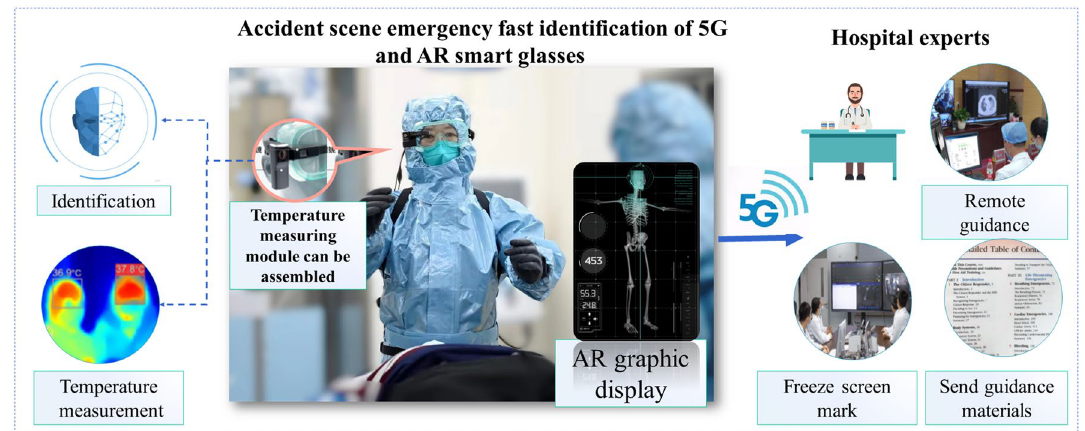
Figure 7. AR smart glasses